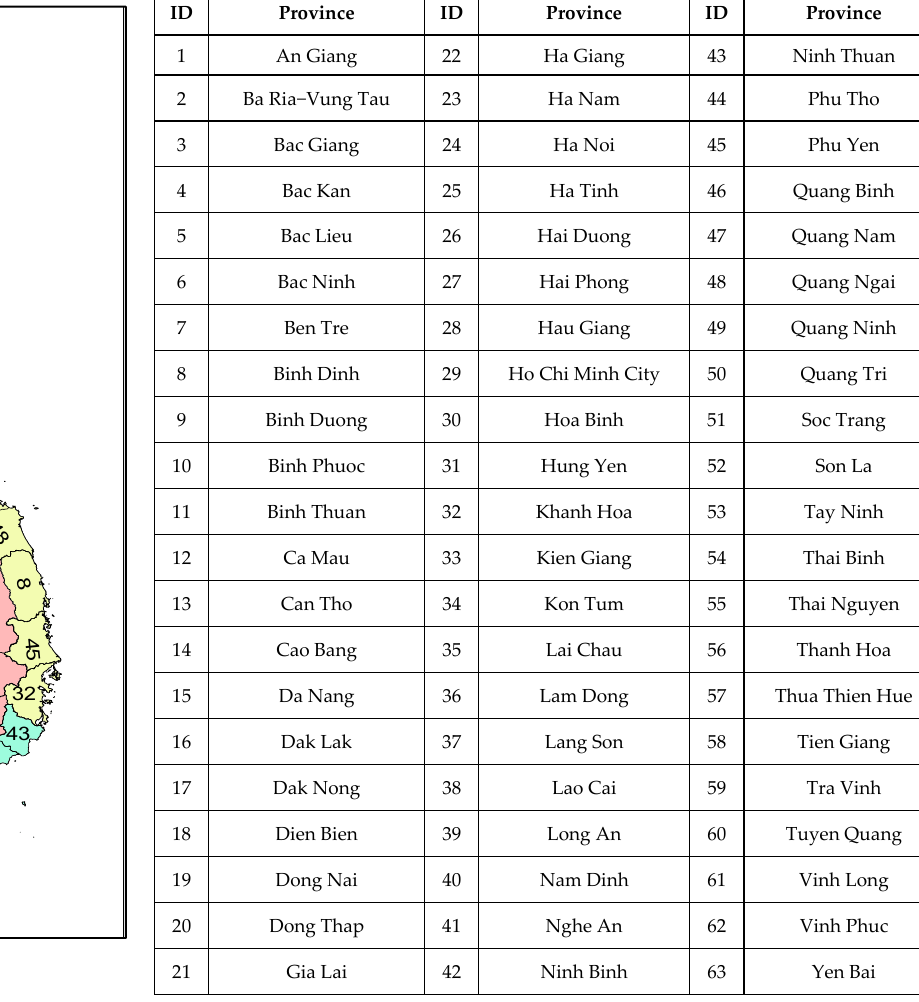
Figure A2. Administration map of Vietnam: Regions and Name & ID of Provinces.